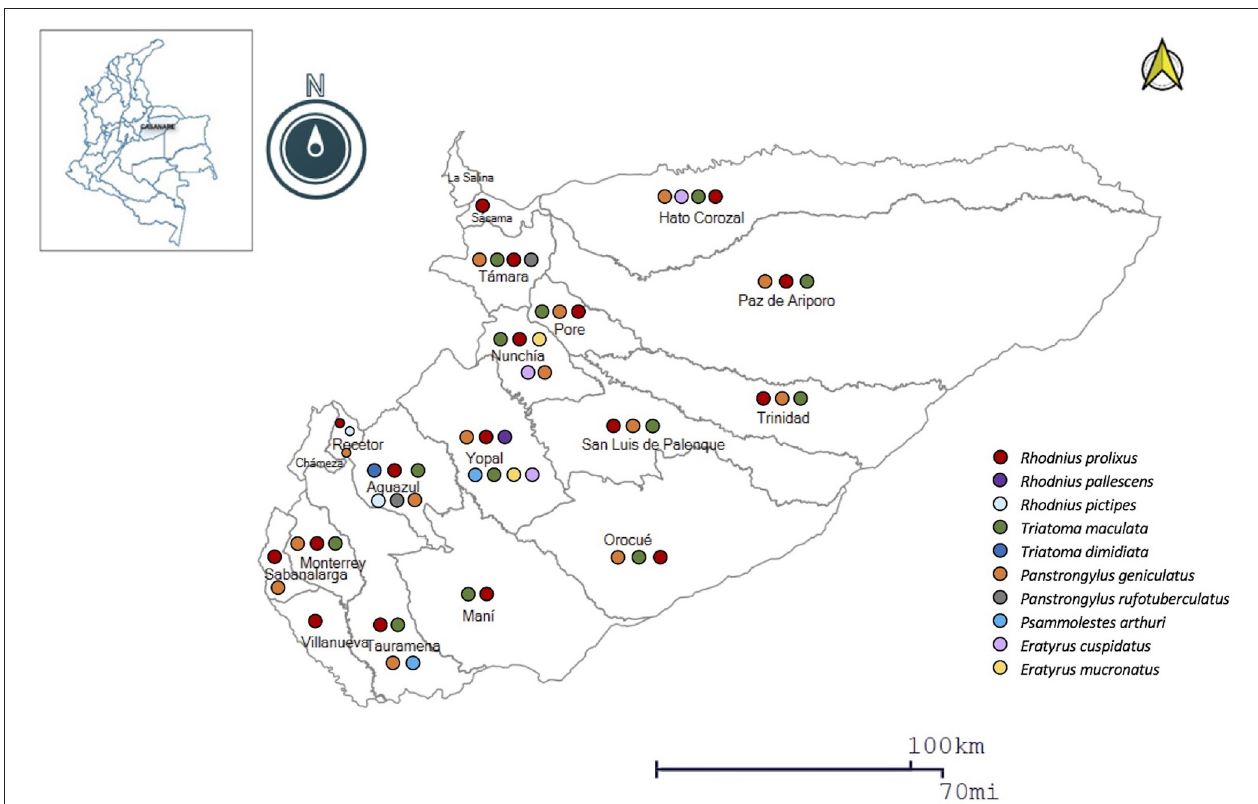
FIGURE 3 | Geographic distribution of the main triatomine species in